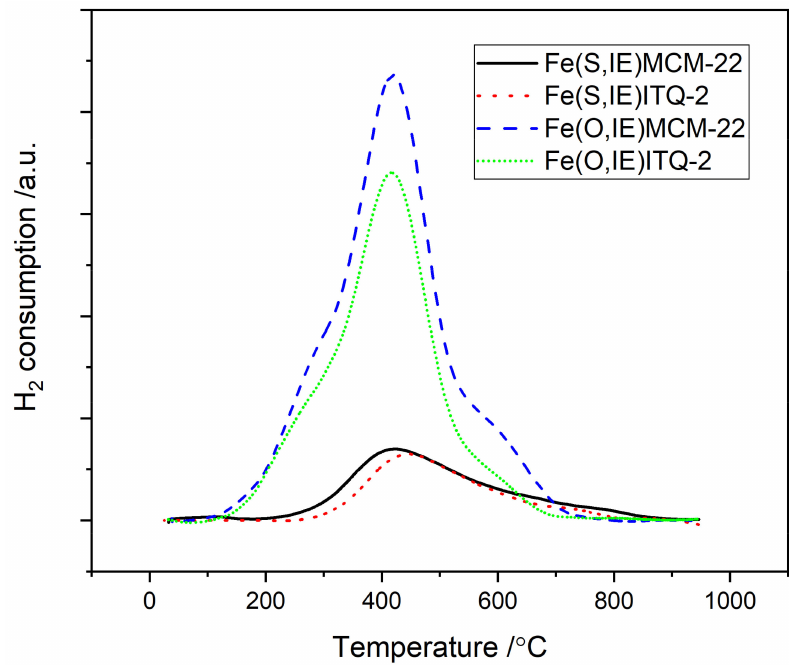
Figure 4. H 2 -TPR profiles of the MCM-22 and ITQ-2 samples modified with FeSO 4 · 7H 2 O